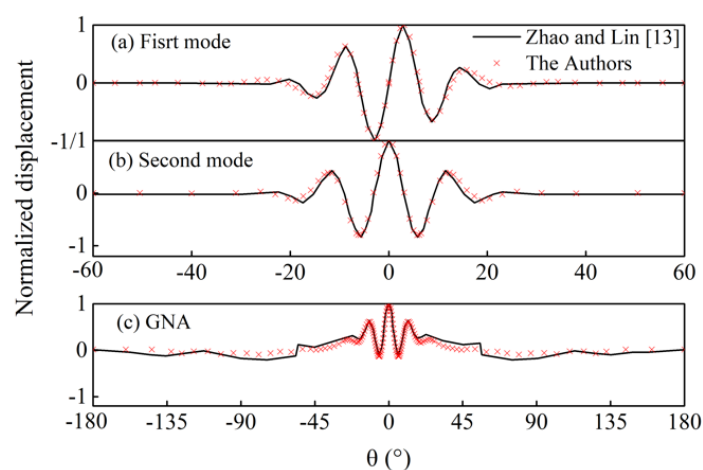
Figure 9. Deformations of the LAB and the GNA for the 100,000 m 3 steel tank.